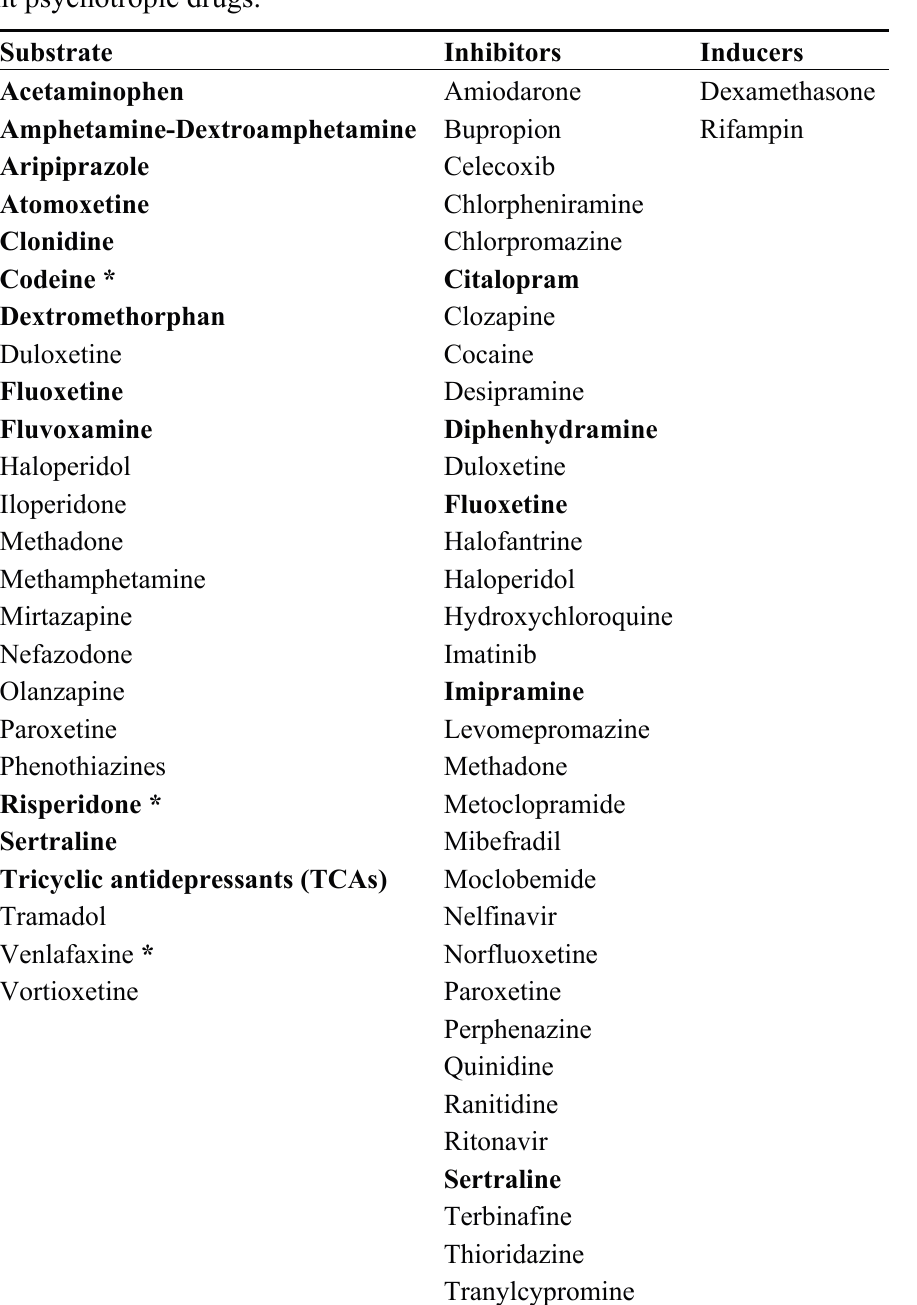
Table 1. Pharmacologic substrates, inhibitors and inducers of cytochrome P450 (CYP2D6) of relevant psychotropic